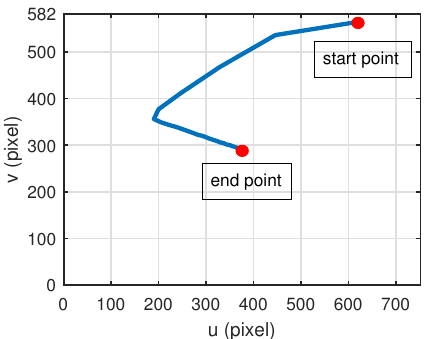
Figure 7. The projection trajectory on the image plane.